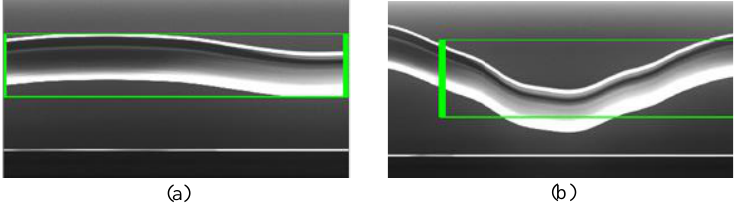
Figure 6. Position recognition of the contact wire based on the classical Siamese region proposal network (RPN). ( a ) The 8th frame. ( b ) The 91st frame.